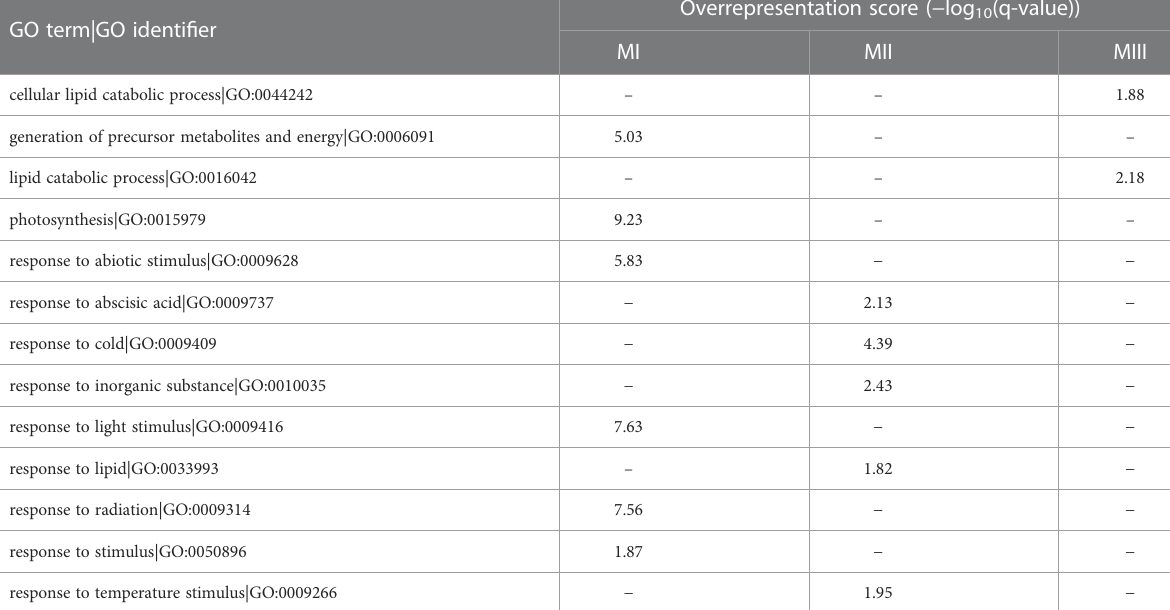
TABLE 3B GO Slim terms overrepresentation analysis of three joined co-reaction